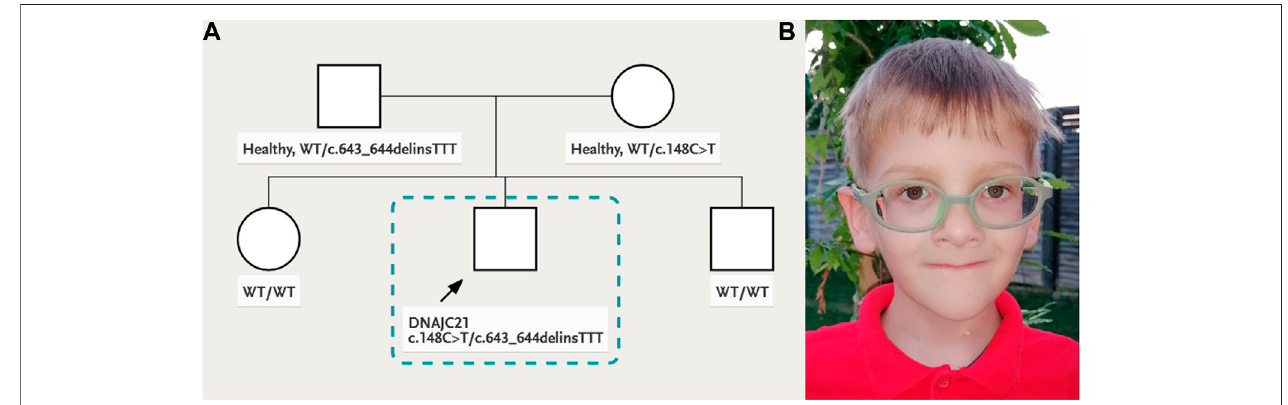
FIGURE 1 | (A) Family pedigree and (B) patient ’ s facial phenotype: deep-set eyes, palpebral ptosis, triangular face, and thin